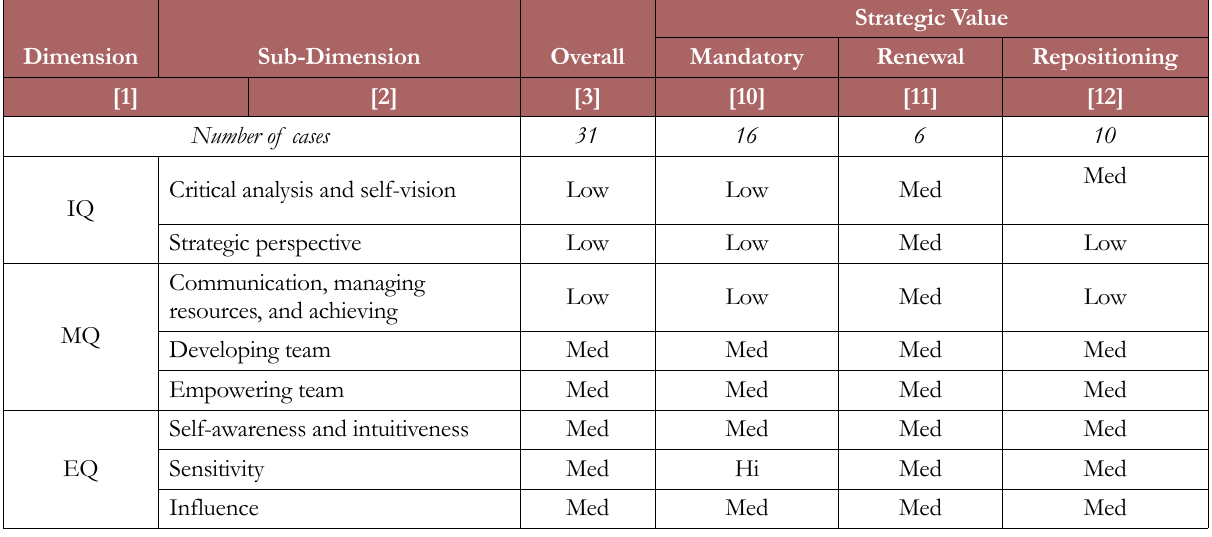
Table 8. The Leadership Competency Map for Less Successful Projects (Strategic Value, as a Moderating